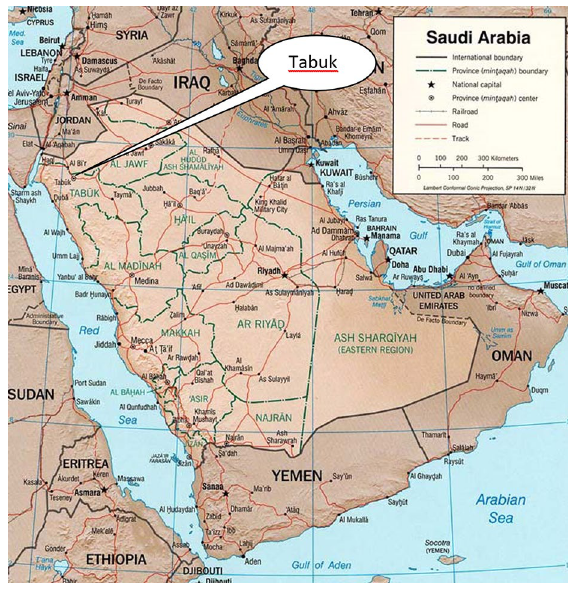
Fig. 1. Location of Tabuk region